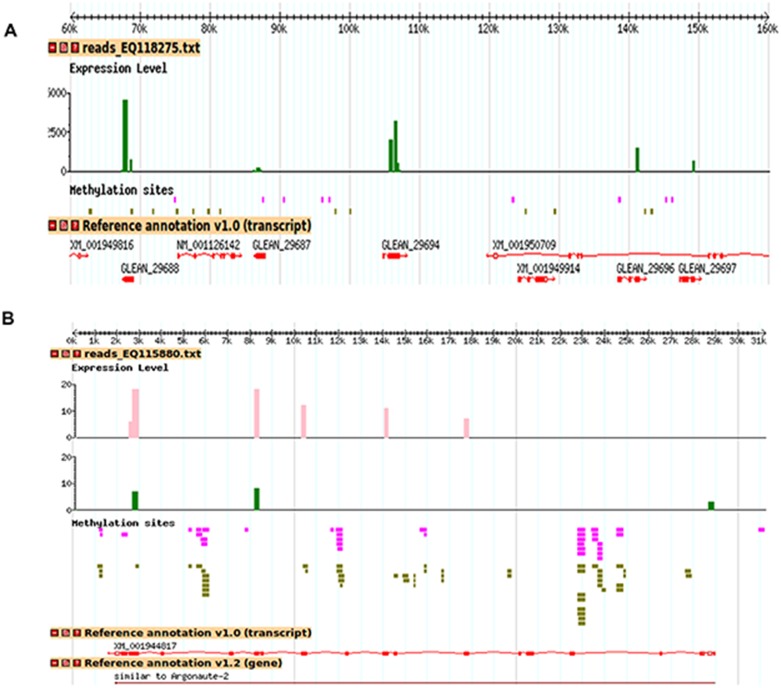
Representative scaffolds decorated with the mapping of the exact matches corresponding to the methyl reads and the transcriptomic contigs.The methylome reads were directly mapped to the genome scaffolds of A. pisum strain LSR1 version Acyr_1.0 with the program Razers [43]. The contigs were searched for sequence similarity using BLAST [46]. Vertical bars are the number of reads corresponding to the contigated fragments obtained after subtractive enrichment of transcripts (pink for orange aphids and green for green aphids). Each pink and green horizontal trait represents a methyl read that is at least represented twice in pyrosequencing in the orange and green aphids and the thick traits are overlapping or contiguous reads. The methyl reads were mapped on scaffolds disregarding the fact that some of them match the genome elsewhere. (A) One scaffold shows a strong gene expression of five genes in the green aphids, whereas these transcripts are absent in the orange. (B) Expression and methylation of one specific gene encoding Argonaute-2.